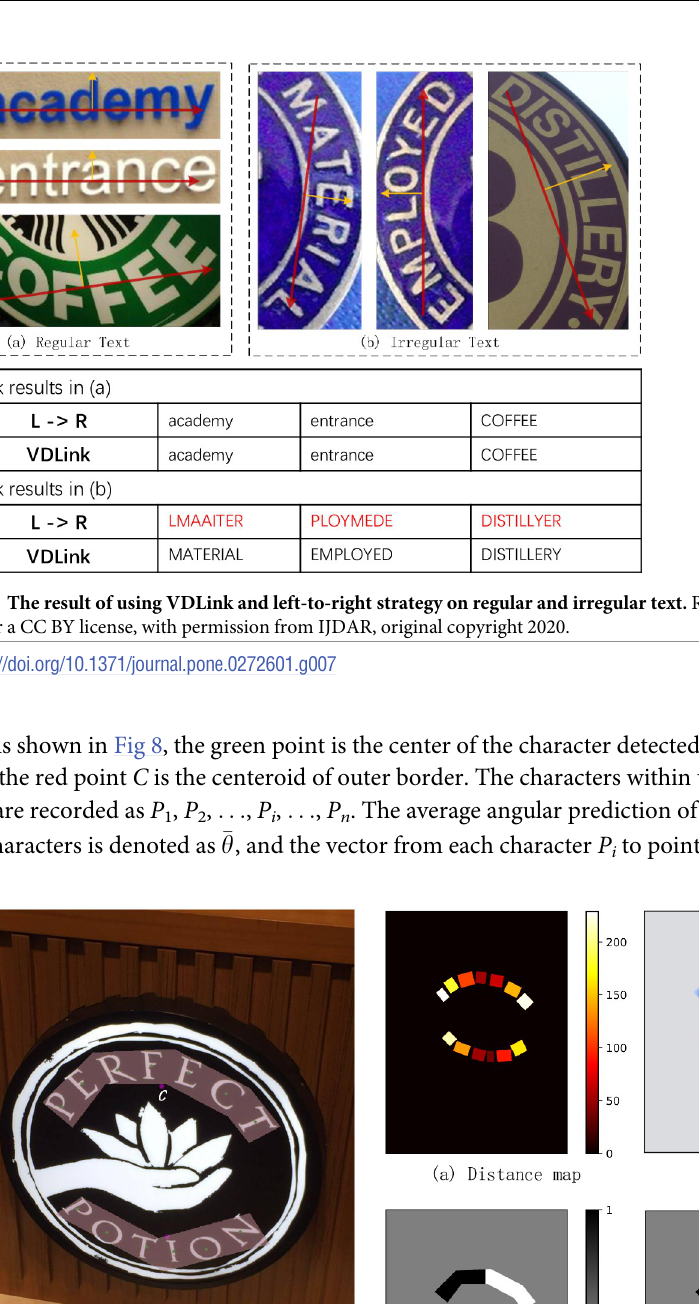
Fig 8. Diagram of VDLink’s processing. In the picture on the left, the green point is the center of the character detected by MA-CharNet, and the red point C is the centeroid of outer border. (a), (b), (c) and (d) denote the distance from the center of the character to the center of mass of the border, the angular prediction map of the character, the v i value f and VD i value of the character, respectively. Reprinted from [19] under a CC BY license, with permission from IJDAR, original copyright 2020.